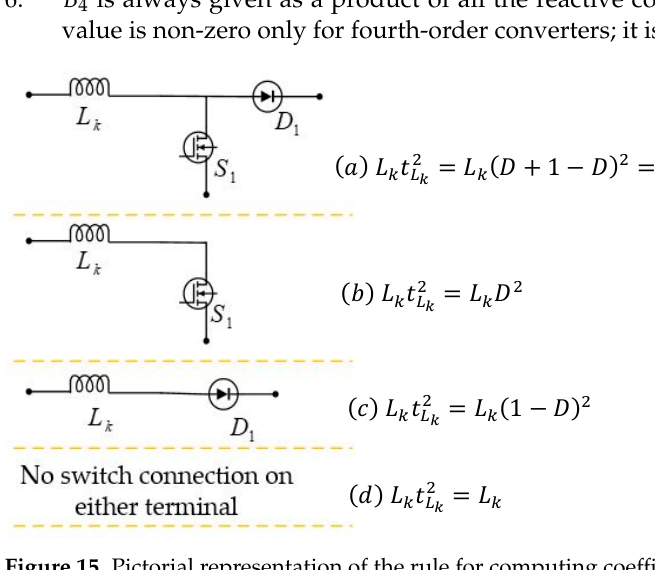
Figure 15. Pictorial representation of the rule for computing coefficient B 1 .